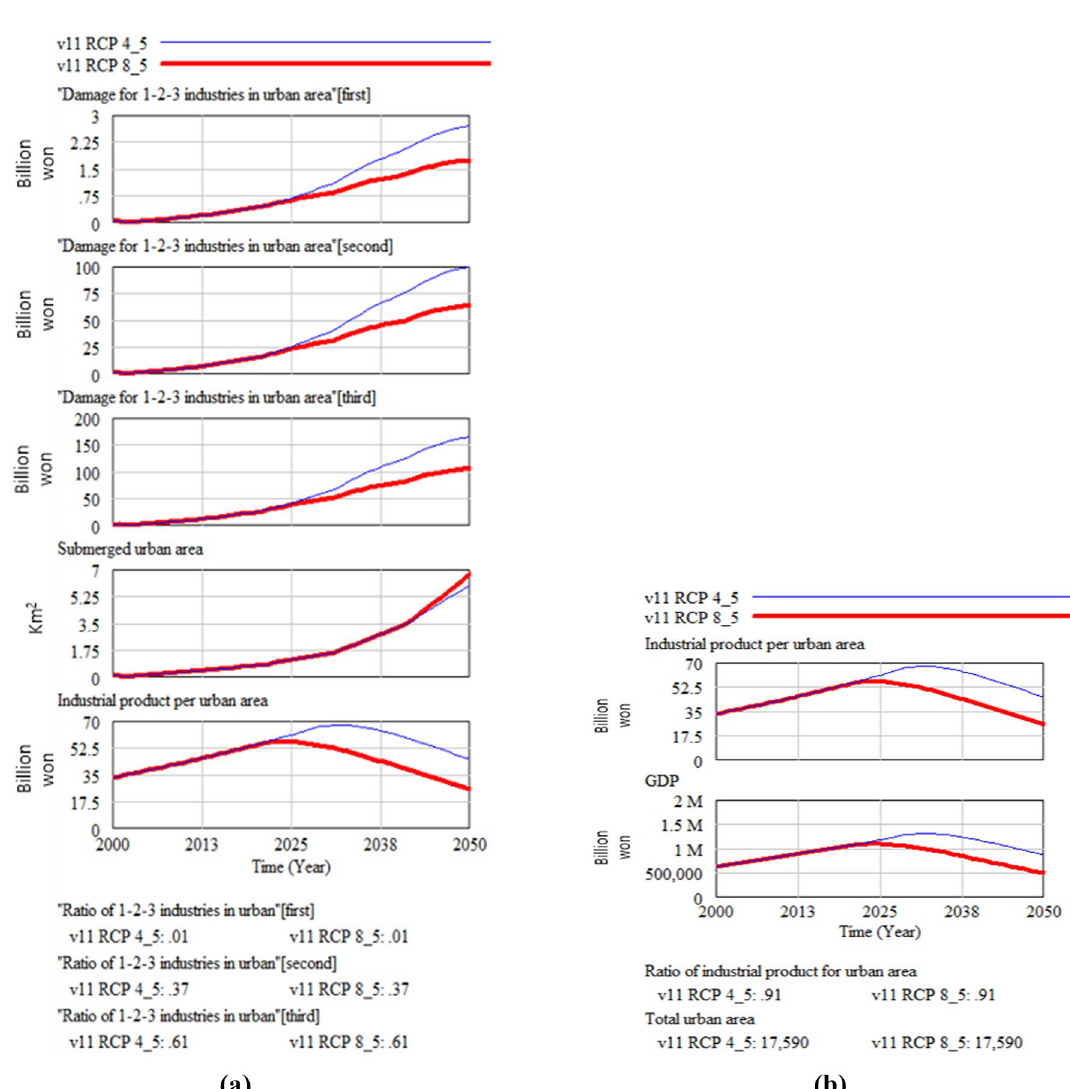
Figure 22. Total urban industrial output, gross domestic product (GDP), and industrial output per unit of urban